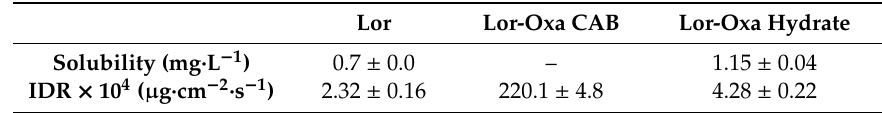
Figure 9. ( a ) Intrinsic dissolution profiles of Lor, Lor-Oxa CAB, and Lor-Oxa hydrate, ( b ) intrinsic dissolution profiles of Lor and Lor-Oxa hydrate, ( c ) PXRD pattern of Lor-Oxa CAB pellet after IDR study in comparison to those of Lor-Oxa CAB and Lor-Oxa hydrate, and ( d ) turbid dissolution medium after IDR experiment, suggesting bulk precipitation. Table 2. Solubility at 25 ◦ C and intrinsic dissolution rate at 37 ◦ C of Lor, Lor-Oxa CAB, Lor-Oxa hydrate in pH 6.8 phosphate bu ff er ( n =